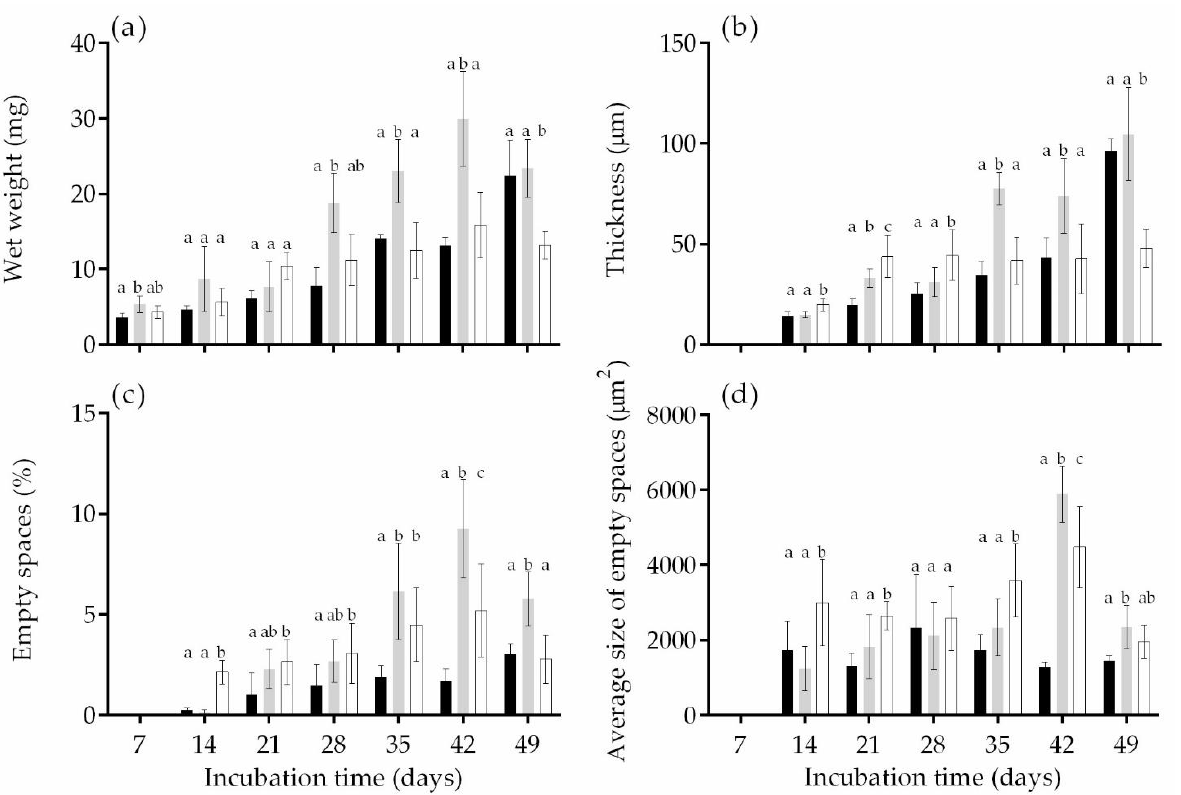
Figure 5. Lusitaniella coriacea LEGE 07157 biofilm development on different surfaces: glass (black), epoxy resin (grey), GNP composite (white). The parameters analyzed refer to biofilm wet weight ( a ), biofilm thickness ( b ), average percentage of empty spaces ( c ), and their respective average size ( d ) on biofilm structure. Mean values and SD from two biological assays with two technical replicates each are represented. For each sampling day, different lowercase letters (a, b, and c) indicate significant differences between surfaces ( p < 0.05).